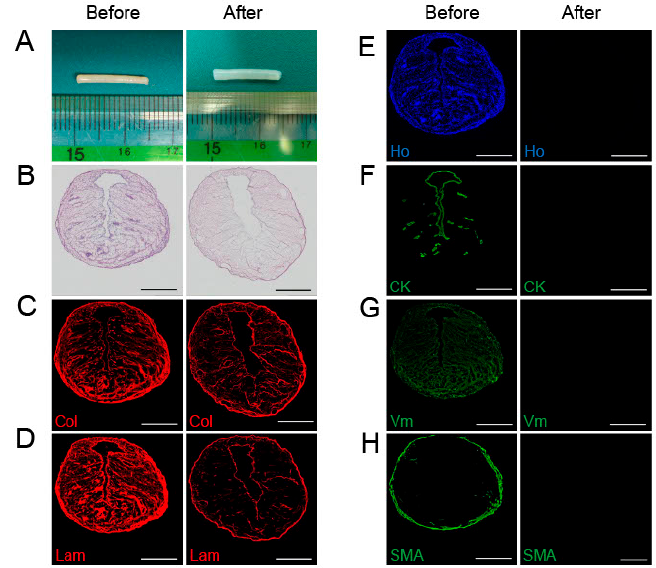
Figure 2. Preparation and characterization of decellularized rat endometrial scaffolds (DES). ( A ) The excised cylindrical endometrium was cut into 1.5 cm long pieces. ( B – H ) Endometrial pieces before (left panels) and after (right panels) decellularization were cross-sectioned and subjected to H&E staining ( B ) and immunofluorescence staining using antibodies against collagen type I (Col) ( C ), laminin (Lam) ( D ), Hoechst (Ho) ( E ), CK ( F ), Vm ( G ), and SMA ( H ). Scale bars, 500 µm.